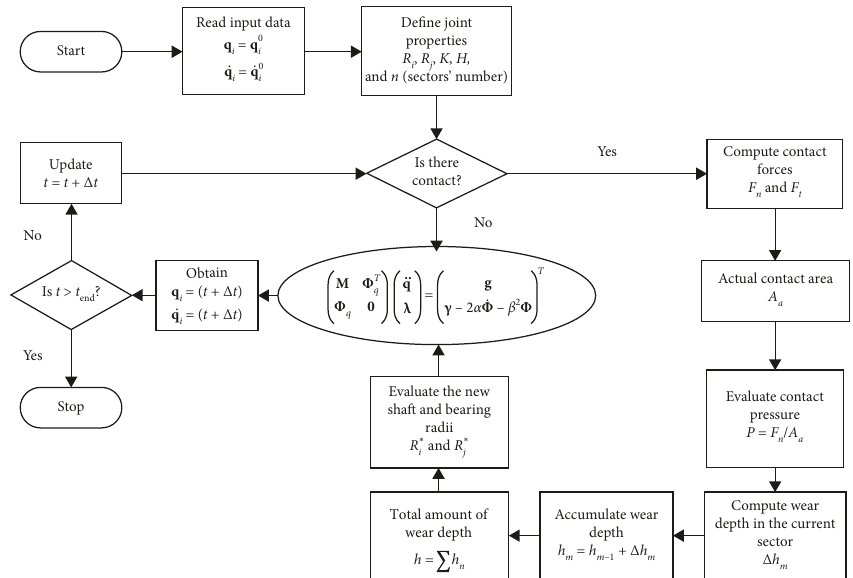
Figure 4: The dynamic and wear integration frame. Table 1: Dimensions and mass properties.